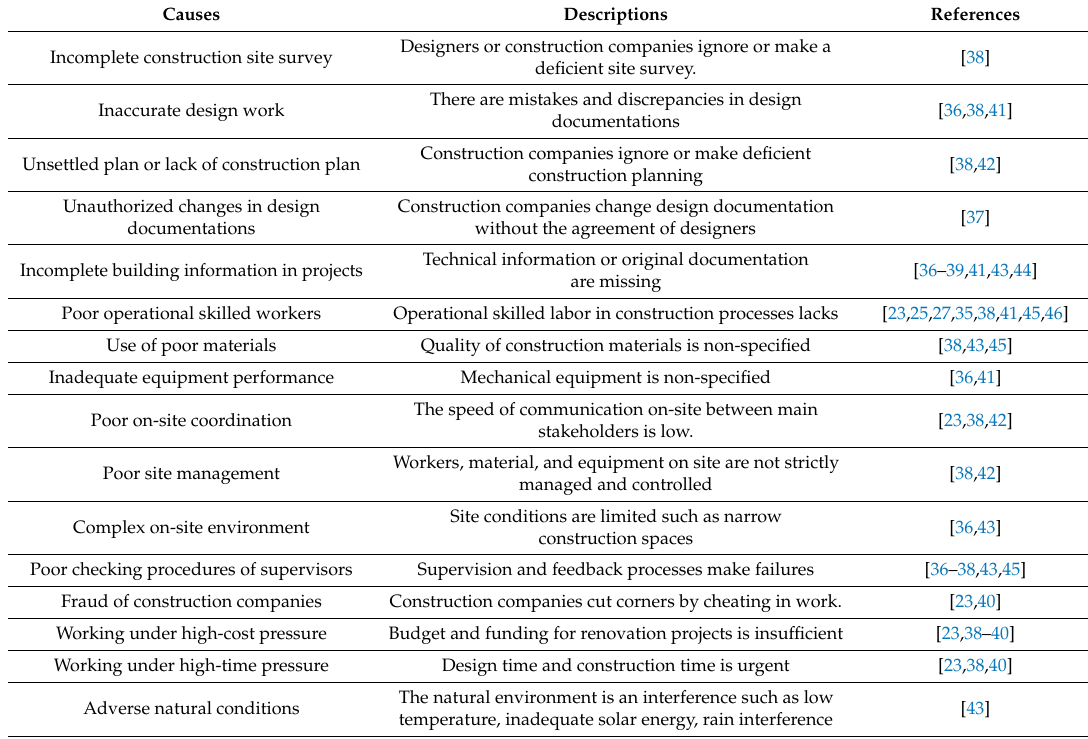
Table 1. List of identified causes from a literature